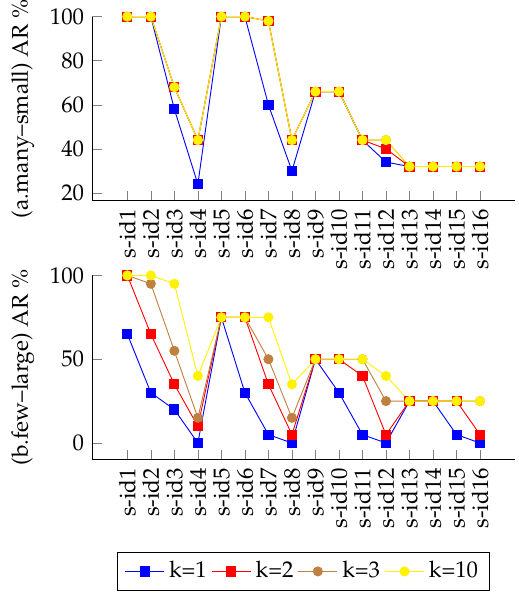
Figure 8. Success rate of “k” variations on Greedy-kSP.